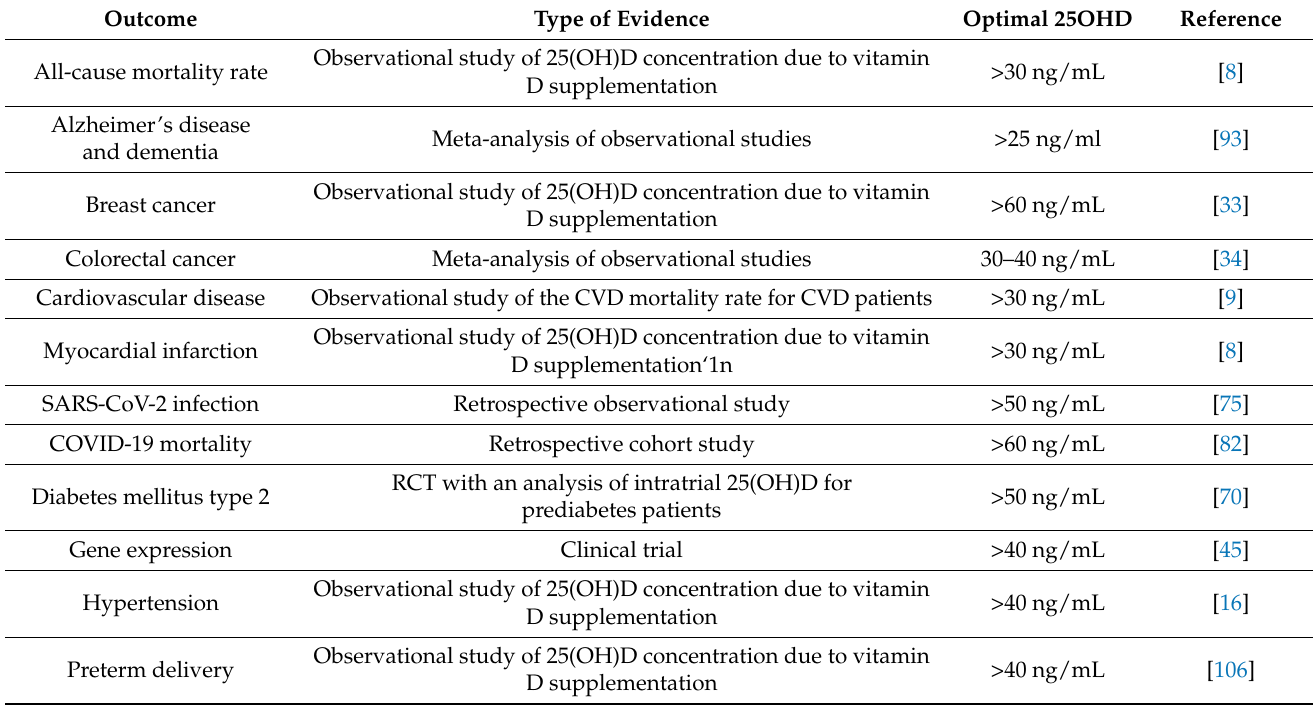
Table 5. Optimal 25(OH)D concentrations for various health